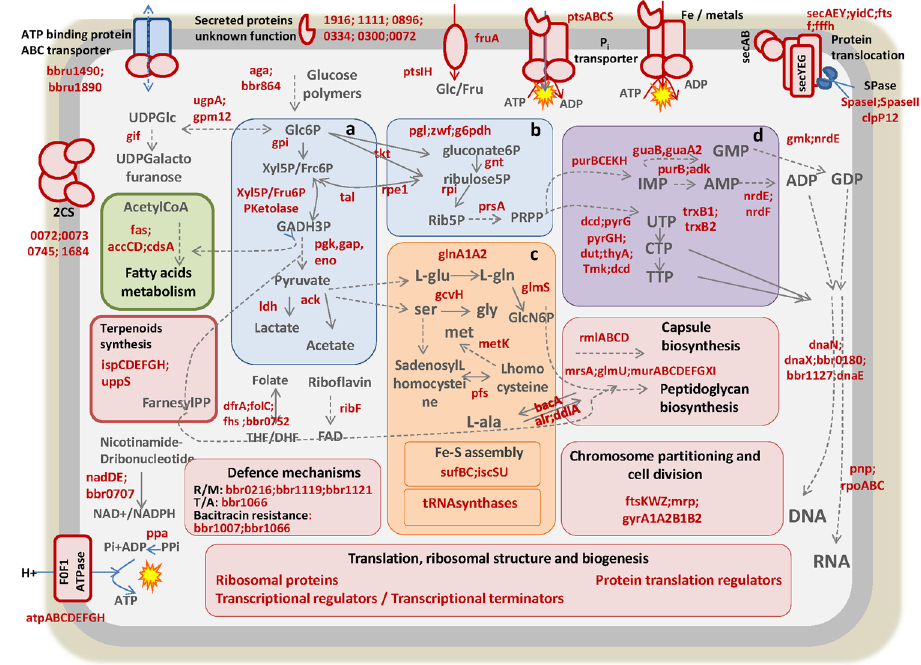
Figure 2. Reconstruction of essential metabolic pathways and functions, based on TraDIS-predicted essential genes in B. breve UCC2003. Gene names or locus tags are represented in red and metabolic intermediates in grey. Dashed arrows summarize multiple reactions. Panels A and B represent the essential central carbohydrate utilization pathways, bifid shunt and pentose phosphate pathway, respectively. Panel C represents essential steps within amino acid metabolism and biosynthesis pathways. Panel D highlights essential steps mapped onto nucleotide metabolic